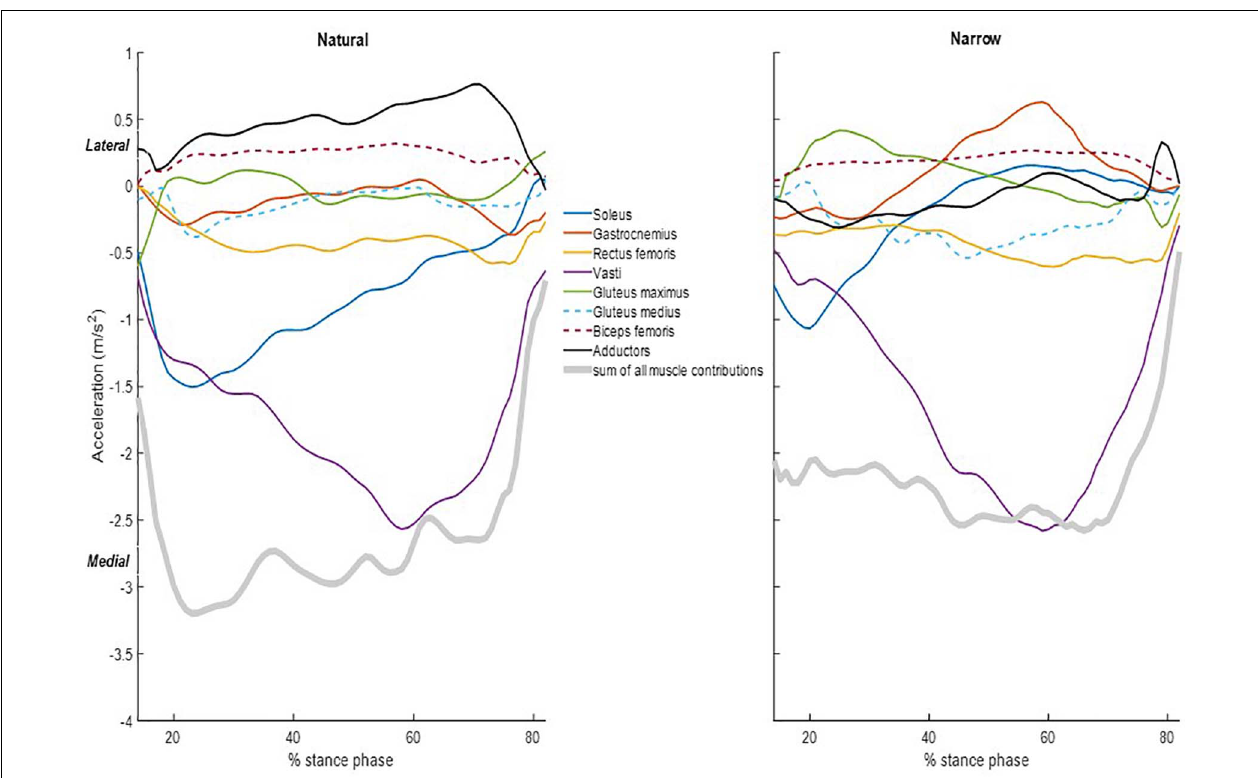
FIGURE 3 | Individual muscle contributions and sum of all the muscle contributions to the medio-lateral COM acceleration during the stance phase in the natural (left) and narrow (right) trials. Data included are the average of all the subjects. Lower-limb muscles considered were soleus (blue), gastrocnemius (orange), rectus femoris (yellow), vasti (purple), gluteus maximus (green), gluteus medius (dashed light blue), biceps femoris long head (dashed maroon), and adductors (black). Muscle contributions are shown only between 14 and 82% of the stance phase.